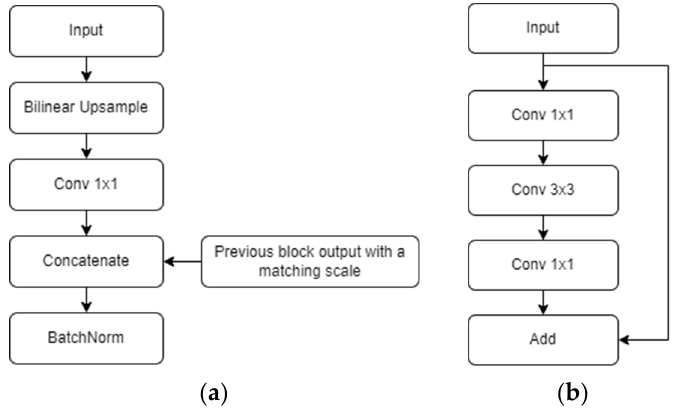
Figure 5. Used structures of inner blocks: ( a ) merge block; ( b ) residual block.